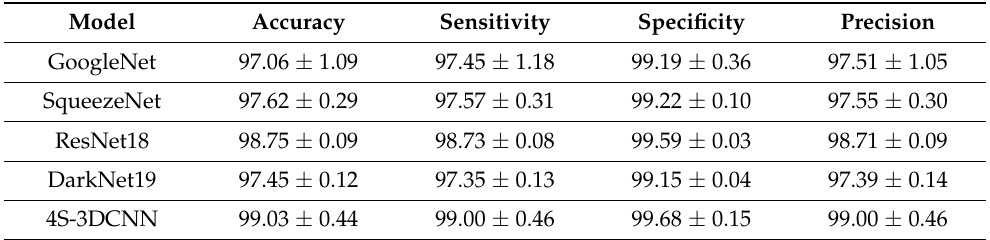
Table 4. Human fall detection results using the 3-fold cross-validation approach (averaged over 3 folds of each model (mean ±